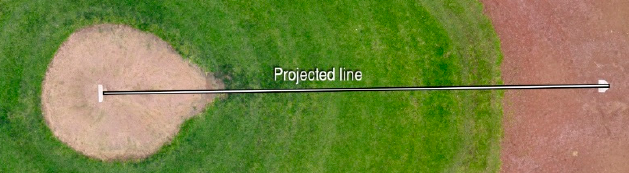
Figure 8. Reconstructed orthophoto from multiple photographs.